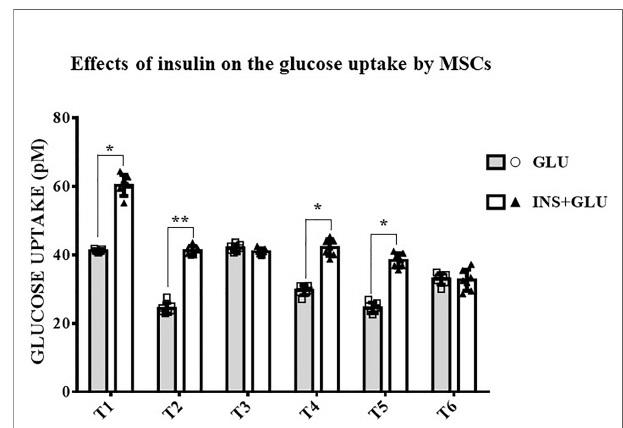
FIGURE 4 | Responsiveness of MSCs to insulin. The bars show the glucose uptake expressed in pM at T1, T2, T3, T4, T5 and T6 in insulin-stimulated or non-stimulated MSCs. Unpaired t-Student ’ s test; *p < 0.05, **p < 0.01. GLU: Cells exposed to glucose; INS+GLU: Cells stimulated with insulin before glucose exposure. Data are expressed as mean ± SD of the readings for MSCs derived from each single patient over three independent experiments.